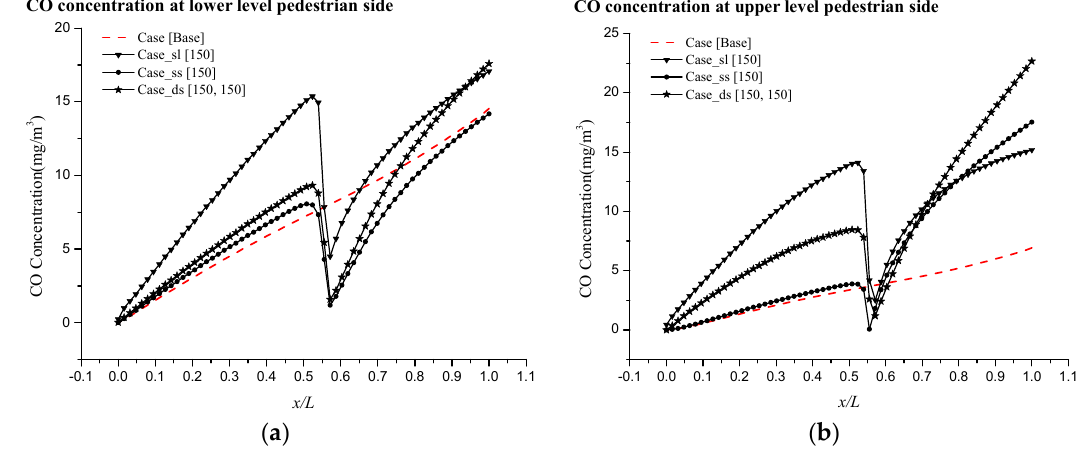
Figure 11. CO concentration along the left-pedestrian side in cases with three basic catcher arrangements CO concentration at ( a ) lower pedestrian side and ( b ) upper level pedestrian side.